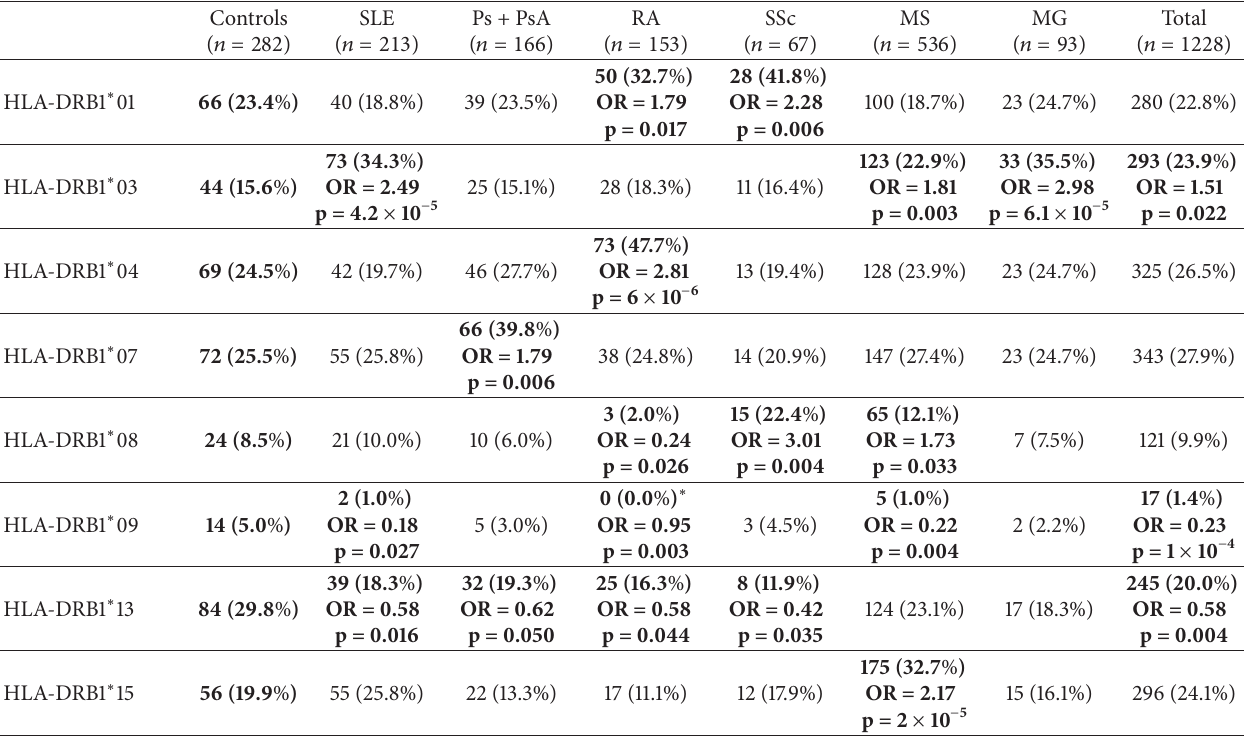
Table 2: Associations between HLA class II and six AIDs: SLE, Ps + PsA, RA, SSc, MS, and MG.